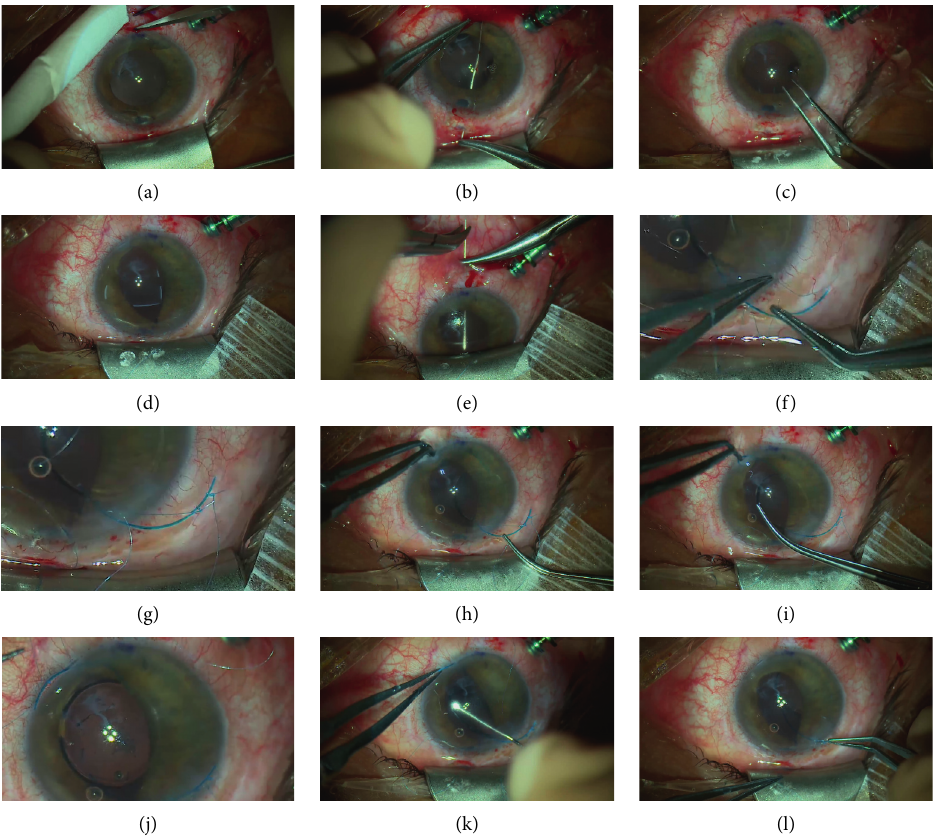
Figure 1: Most important steps of the surgical technique. Intraoperative photographs showing the most important surgical steps (patient 2) (a). Marked sulcus position confirmed with endo-trans-illumination, usually at about 2mm from the limbus (b). Insertion of the needle passing through the upper sulcus to the contralateral cornea by holding the needle at it basis (c); grasping the 10-0 polypropylene thread with the McPherson forceps, starting with the opposite threads (d), both 10-0 polypropylene threads are passed through the main incision and fixed with stripes superiorly. (e) Needle passing through the lower sulcus to the contralateral cornea by holding the needle with the right hand in the middle and then grasping the needle with the second hand at its basis (f); the right hand is grasping the upper left 10-0 polypropylene thread passed under the haptic, whereas the left hand is pushing the upper right thread of 10-0 polypropylene away (g). Both 10-0 polypropylene threads are well tied on the upper haptic (h). Right hand is maintaining the upper haptic to position the lower haptic in the paracentesis, while the left hand grabs the lower haptic with a small McPherson forceps as close as possible to its extremity (i). Externalization of the lower haptic with McPherson forceps (j). First knot is tied over the lower haptic, starting proximal to the optic (i.e., lower right 10-0 polypropylene) (k). Internalization of the lower haptic: the left hand is holding the extremity of the haptic with a McPherson forceps and pushing it inside in a clockwise movement while the other hand is pushing back the IOL’s optic with a vitreous spatula. Same manoeuver with the upper haptic; note the left hand which is pulling on the 10-0 polypropylene to guide the haptic under the iris plane